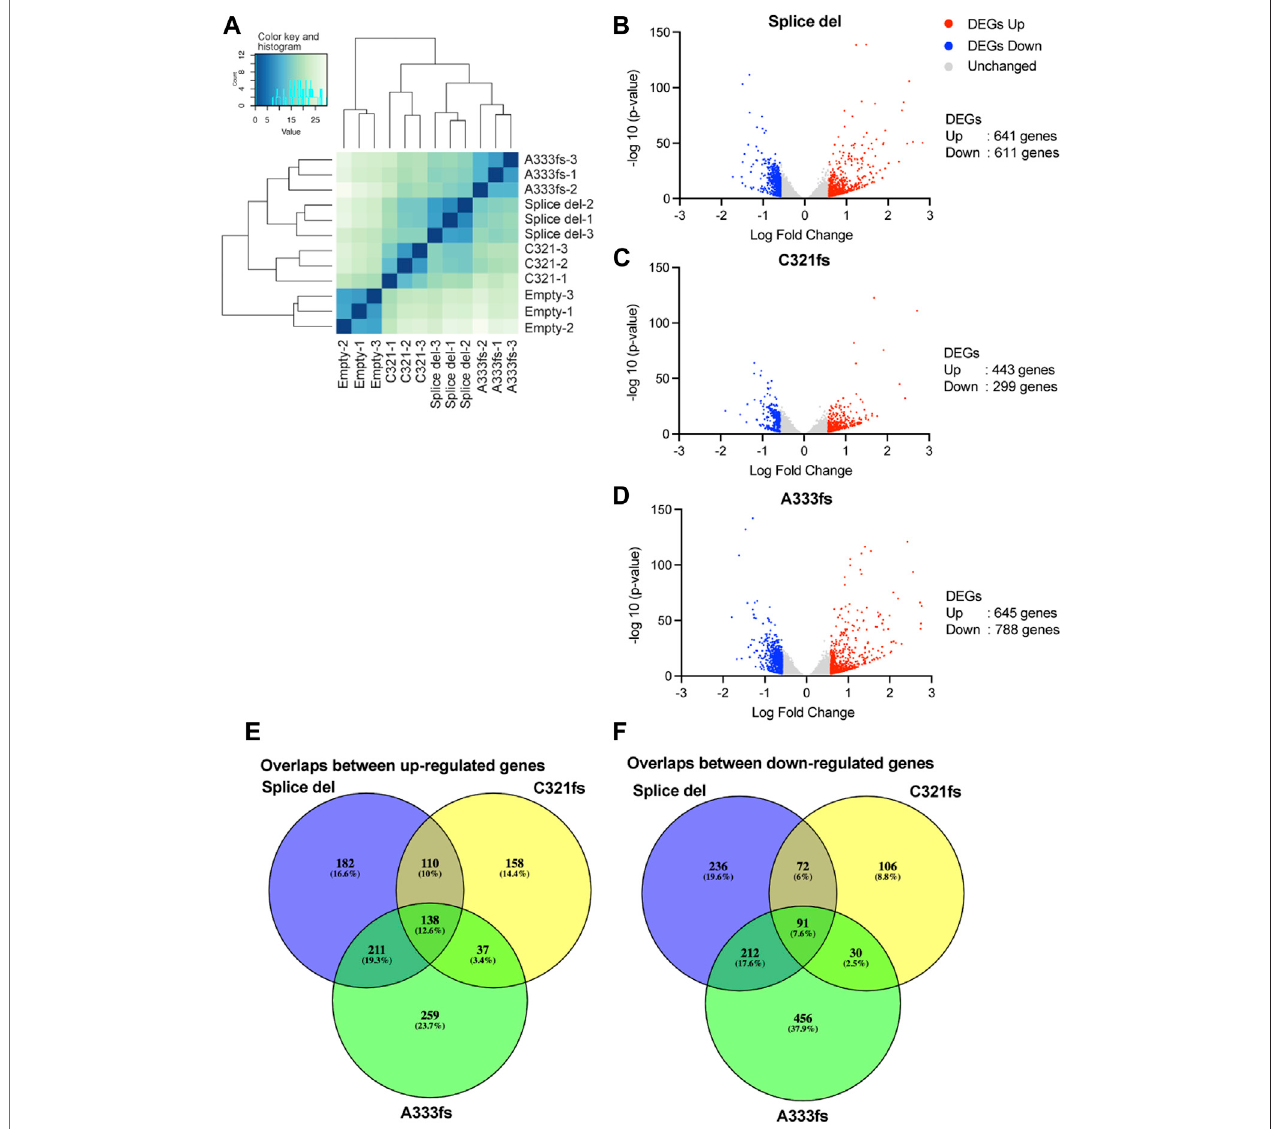
FIGURE 2 | Gene expression analysis in GATA3 truncation mutant cells. (A) Clustered heatmap showing gene expression similarity between Splice del, C321fs, A333fs, and control T47D cells. The scale indicates Euclidean distance. (B) Volcano plot showing differential gene expression between Splice del mutant and control T47D cells. (C) Volcano plot showing differential gene expression in C321fs mutant cells. (D) Volcano plot showing differential gene expression in A333fs mutant expressed cells. FDR < 0.05 and absolute fold change > 1.5 were applied to de fi ne differentially expressed genes. Down- or up-regulated genes are highlighted in blue or red (E,F) Overlap analysis of up- (E) or down- (F) regulated genes between Splice del, C321fs, and A333fs mutant cells.